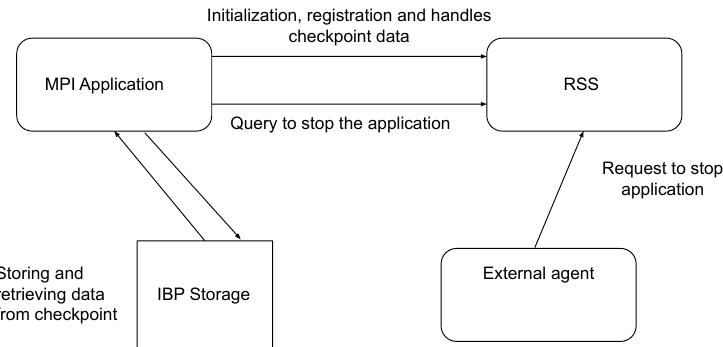
Figure 1. SRS and RSS—interactions between different components in the SRS checkpointing archi- tecture [6]. Based on: